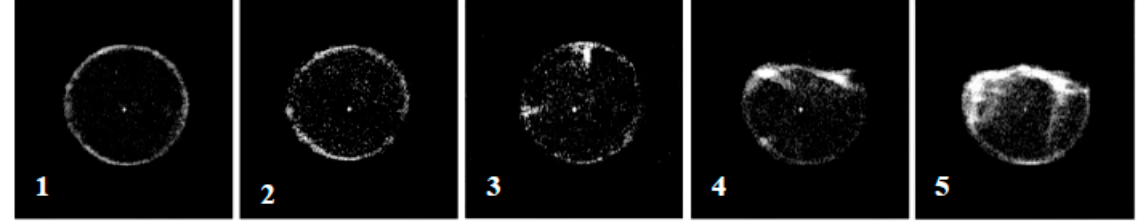
Figure 15. Pore images of saturated rock samples.